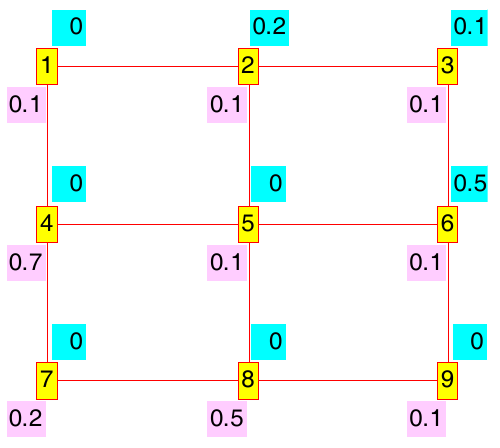
Figure 7. Regular 3 × 3 mesh with city block routes.